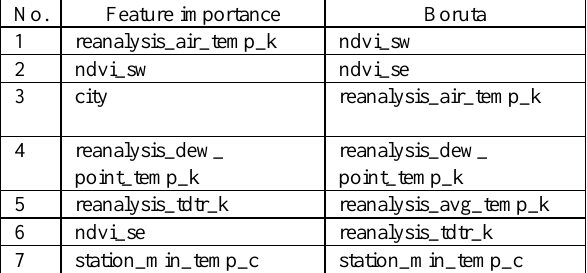
Table 1. Feature